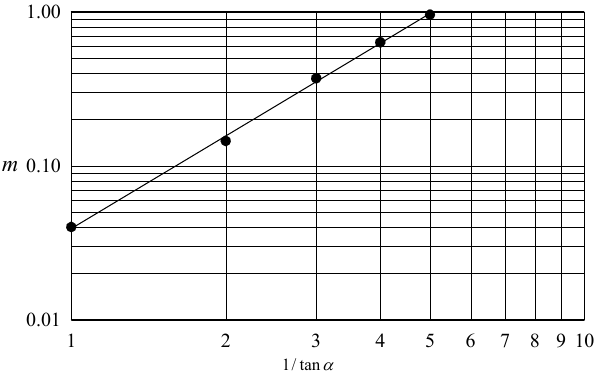
Figure 6. The relation between the gradient m and structure slope tan  . 2 Fig. 6. The relation between the gradient m and structure slope tan α .